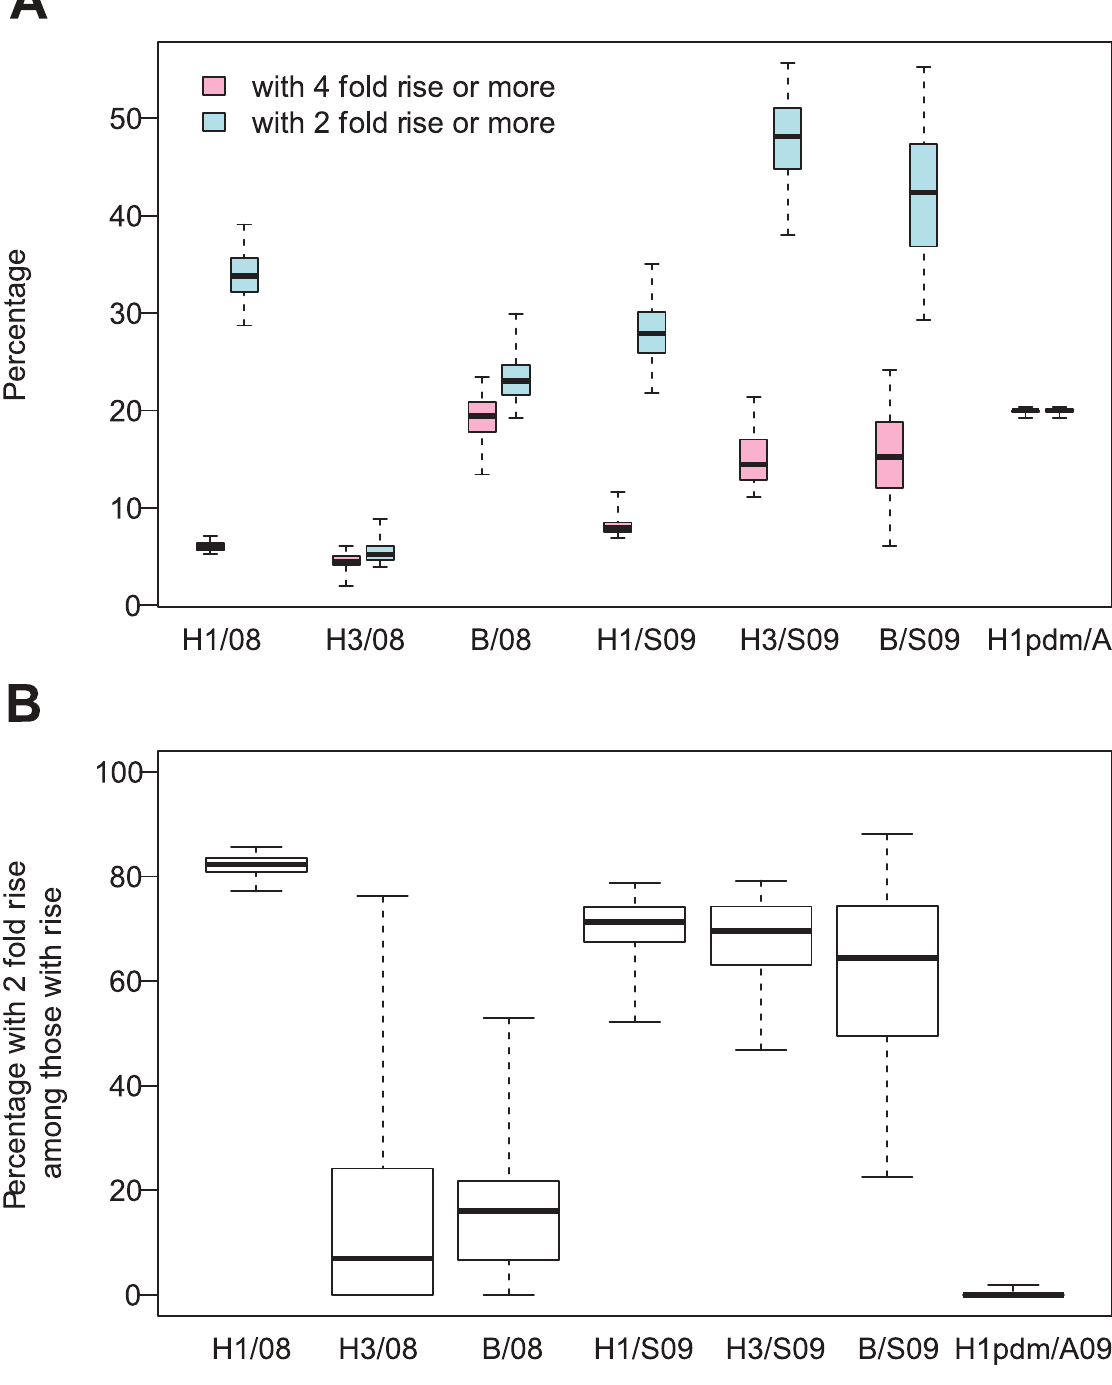
Figure 3. Increases in antibody titers. A : Posterior distribution of the percentage of subjects with a 4 fold rise or more in AT (pink) and with a 2 fold rise or more in AT (blue) for the different subtypes and the different seasons (2008 (08), Spring 2009 (S09), Autumn 2009 (A09)). B : Posterior distribution of the percentage of subjects with a 2 fold rise in AT among those with a rise in AT. Boxplots give percentiles 2.5%, 25%, 50%, 75%, 97.5% of the